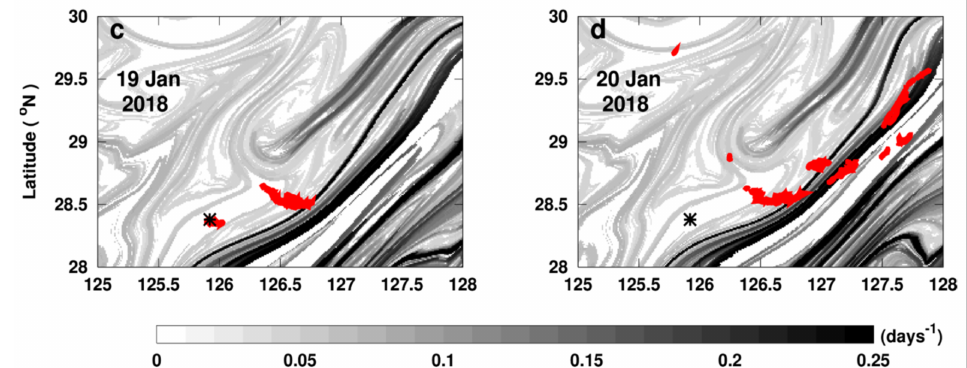
Figure A2. Daily backward finite-size Lyapunov exponent (FSLE) application in the area of the East China Sea oil spill using altimetry and the Ekman product. The black asterisk in all panels indicates the location where the Sanchi tanker sank. The red patch represents the daily evolution of the Sanchi leaked oil path from the 17th to 20th of January 2018 in panels ( a – d ), respectively. The gray-scaled filament-shaped fronts in the background represent daily Lagrangian fronts (FSLE computation using altimetry and the Ekman Copernicus product). The Ekman product, where geostrophic velocity fields are combined with modeled Ekman current, is available at E.U. Copernicus Marine Service Information (CMEMS). Daily global ocean products are used with 0.25 ◦ × 0.25 ◦ spatial resolution